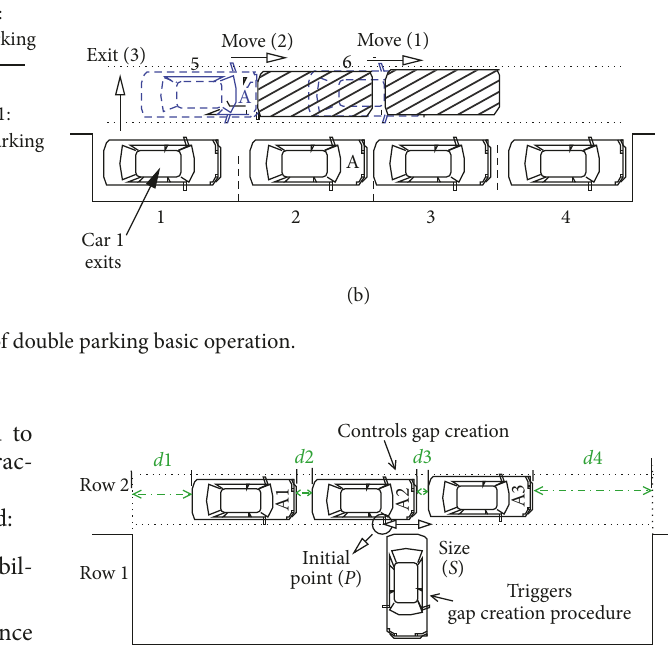
Figure 3: Main elements in gap